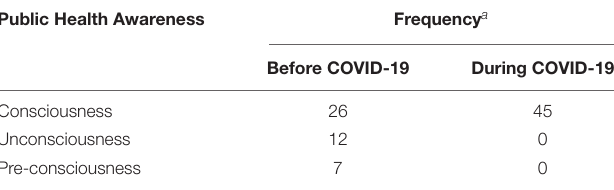
Public Health Awareness